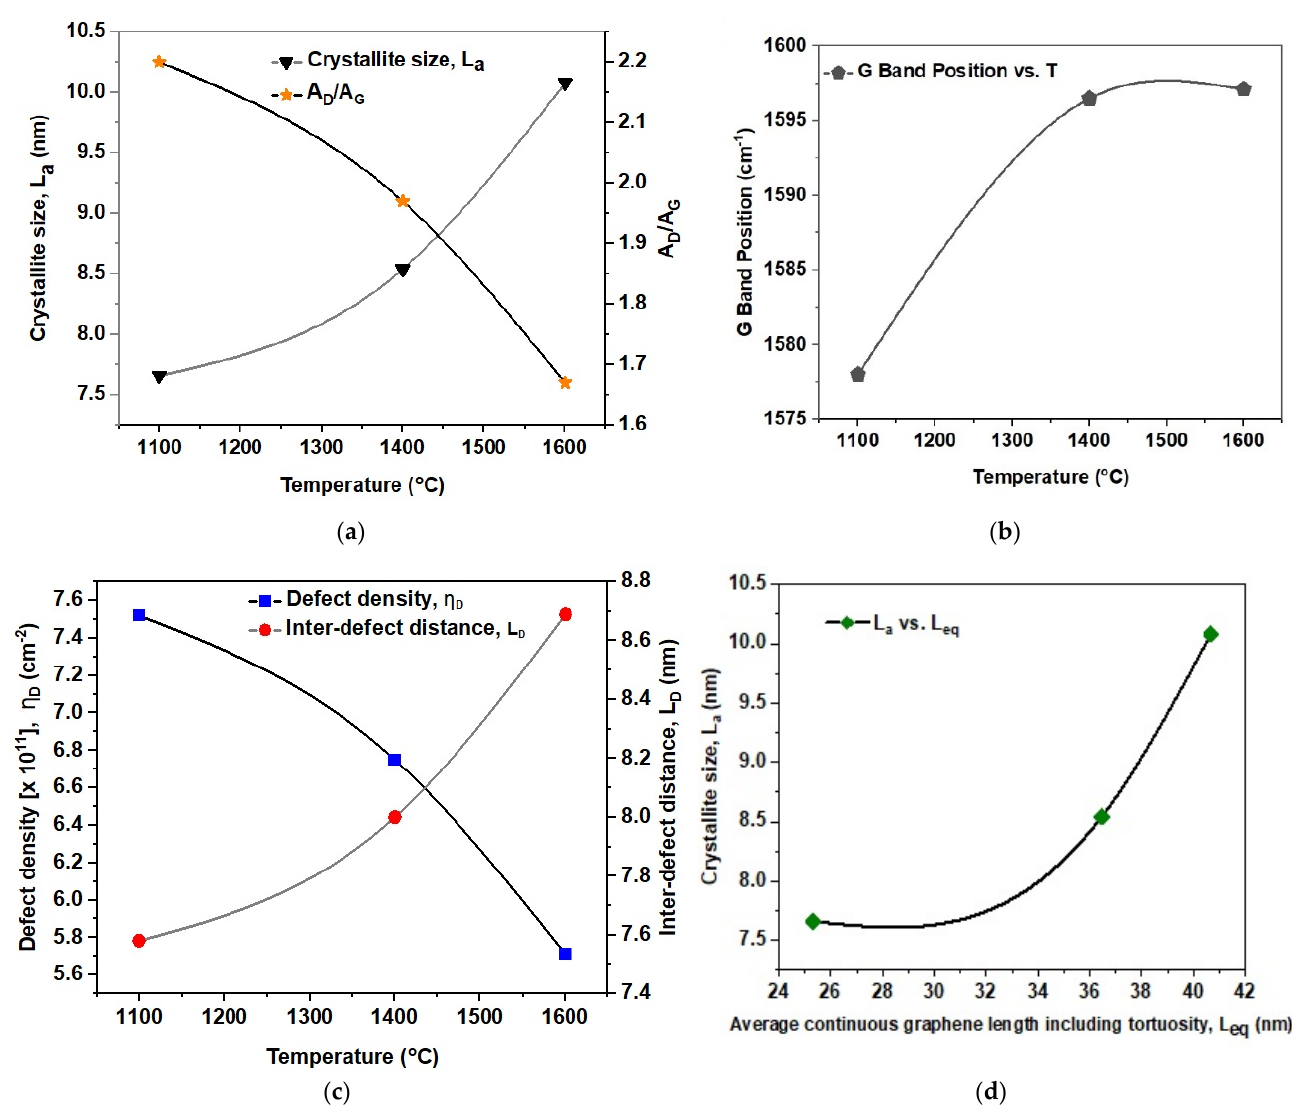
Figure 2. Parameters from Raman spectroscopy which determine the evolution of the sp 2 hybridized carbon phase in the polymer-derived C/SiCN nanocomposite materials: ( a ) Dependence of crystallite size (L a ) and integrated ratios of the D and G bands on temperature; ( b ) shift of the G band as a function of the pyrolysis temperature; ( c ) effect of ceramization temperatures on inter-defect distance (L D ) and defect density ( η D ); ( d ) growth in crystallite size (L a ) of the sp 2 hybridized carbon with an increase in average continuous graphene length including tortuosity (L eq ).